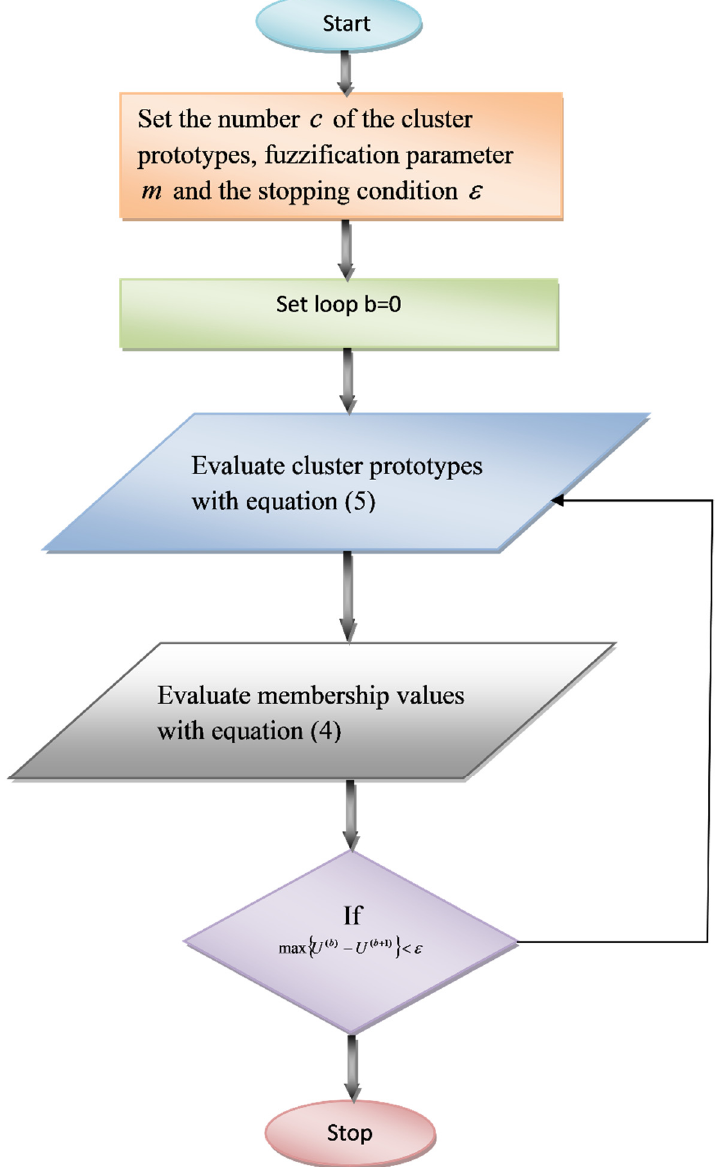
Figure 2. Steps of developed FLIBCM algorithm. The entropy of the feature F is represented in Equation